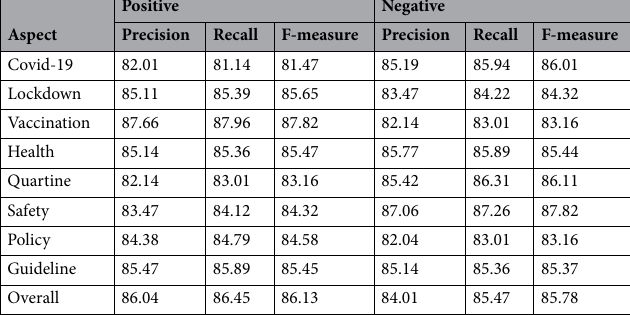
Table 7. Aspect attention base sentiment classification using the proposed method.